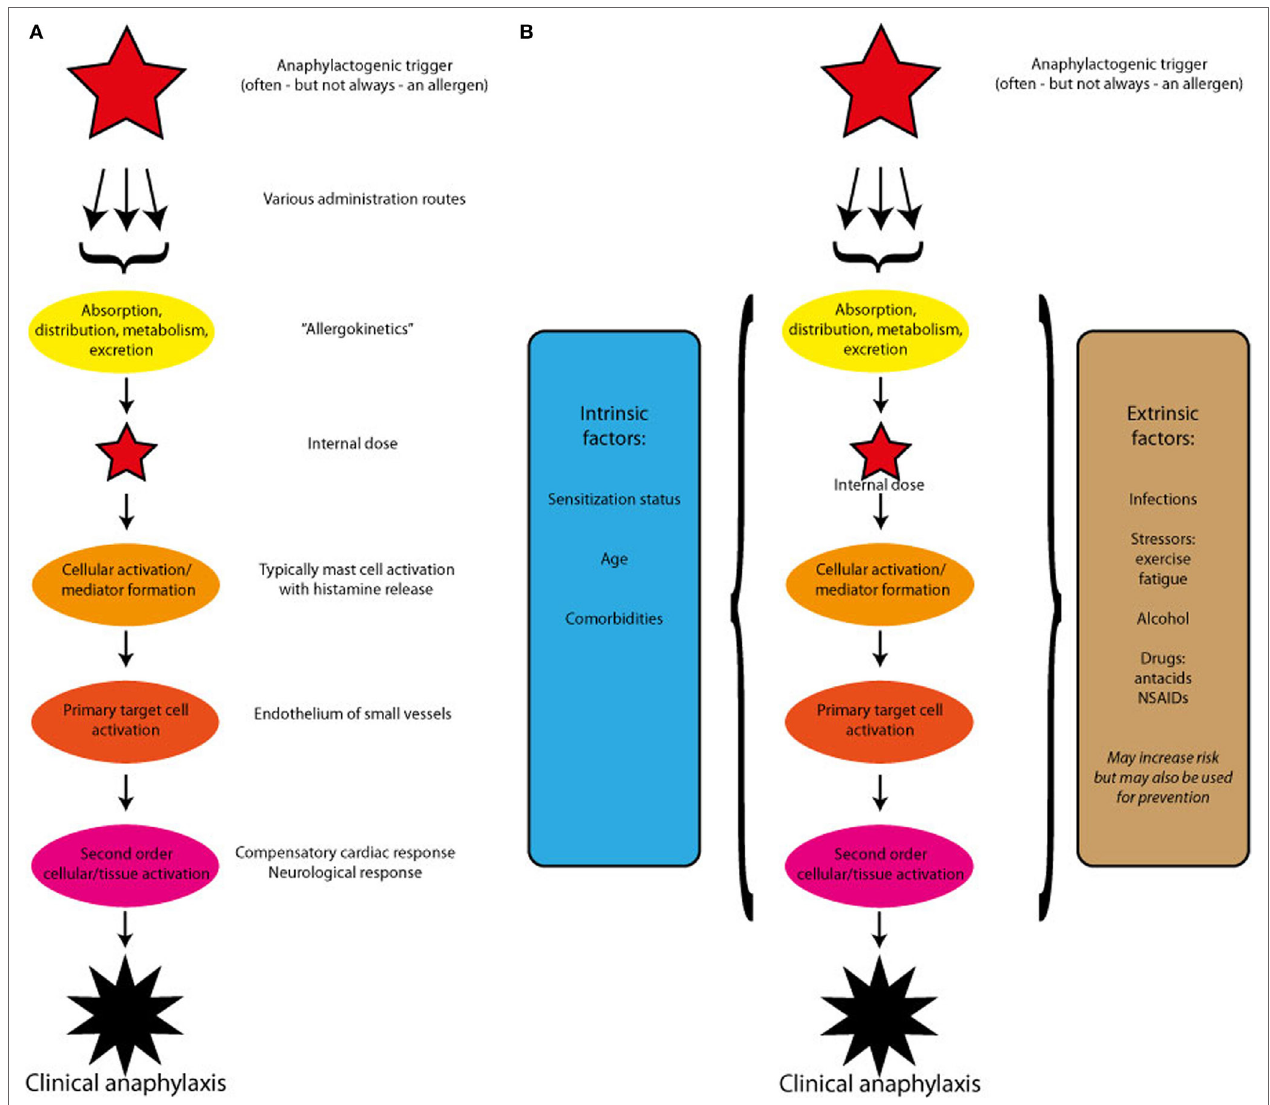
FiGURe 1 | (A) A theoretical outline of the pathogenesis of anaphylaxis induced by a single trigger. After absorption and redistribution, the trigger reaches and activates the effectors cells. The ensuing mediator release induces the primary target cells to react, which may in turn activate compensatory or enhancing mechanisms. (B) A theoretical outline of the pathogenesis of anaphylaxis induced by a single trigger, but modified by host-specific intrinsic and extrinsic factors. The modifying factors may alter each of the steps: cellular activation, primary target cell activation, or secondary cellular or tissues